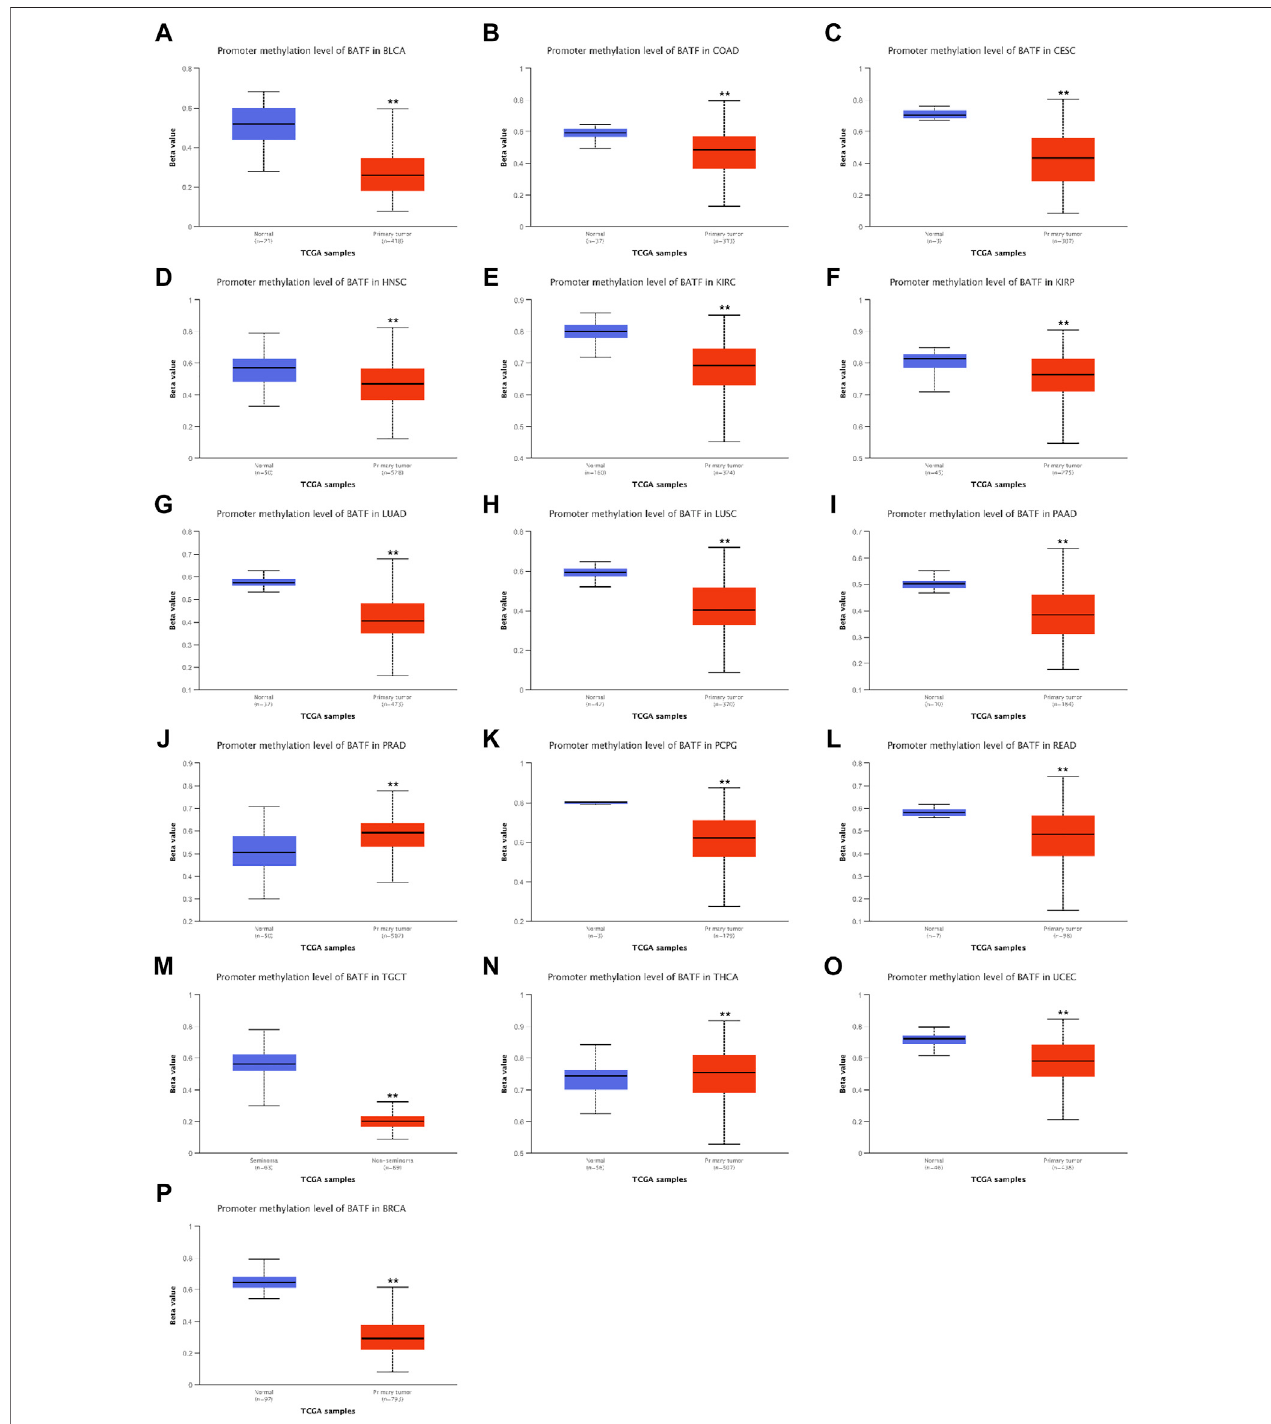
FIGURE 4 | Promoter methylation levels of BATF in pan-cancer. ** p < 0.01 compared with corresponding normal tissues.